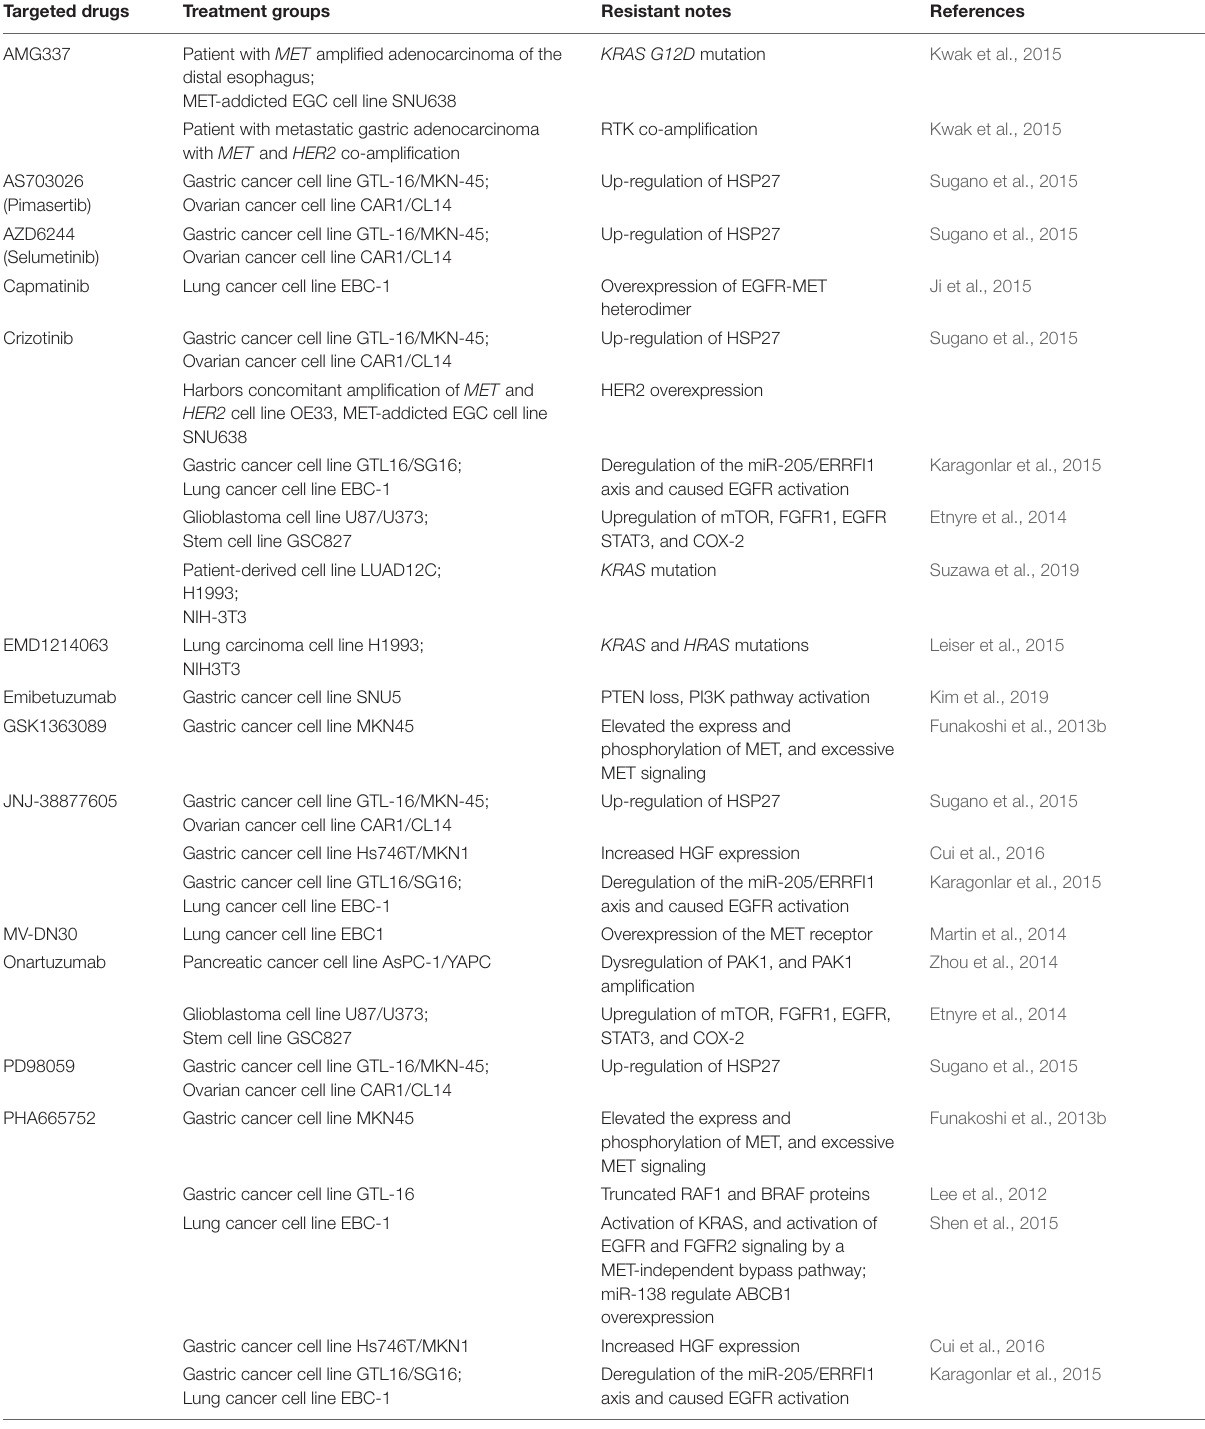
TABLE 2 | HGF/MET-associated oncogenic activation in therapeutic